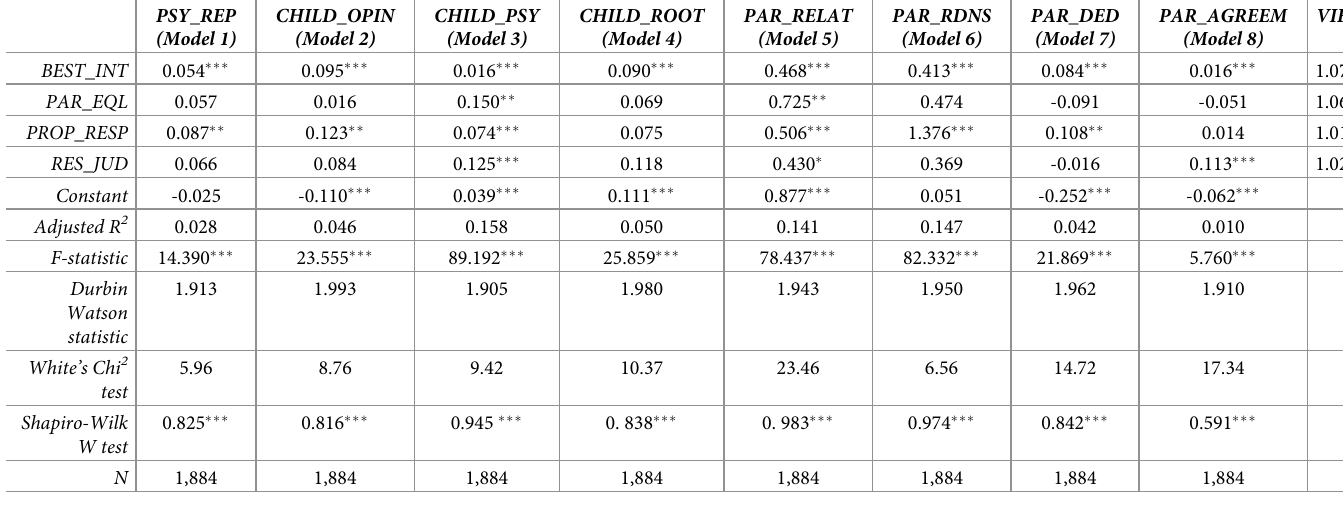
Table 6. Multivariate linear regressions relating factual elements to legal